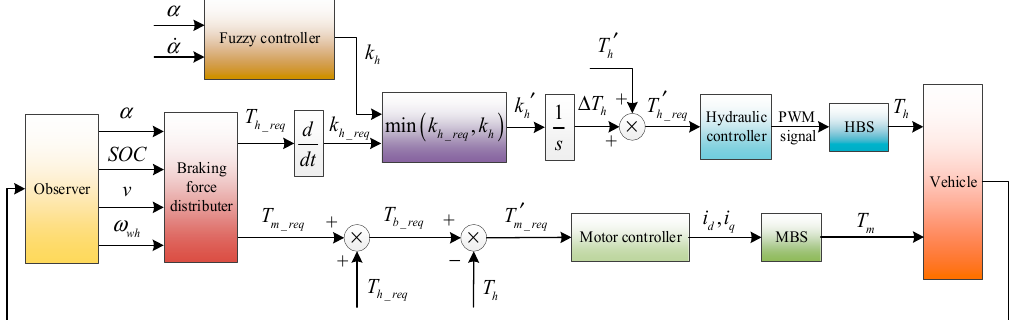
Figure 8. Dynamic coordination control structure.